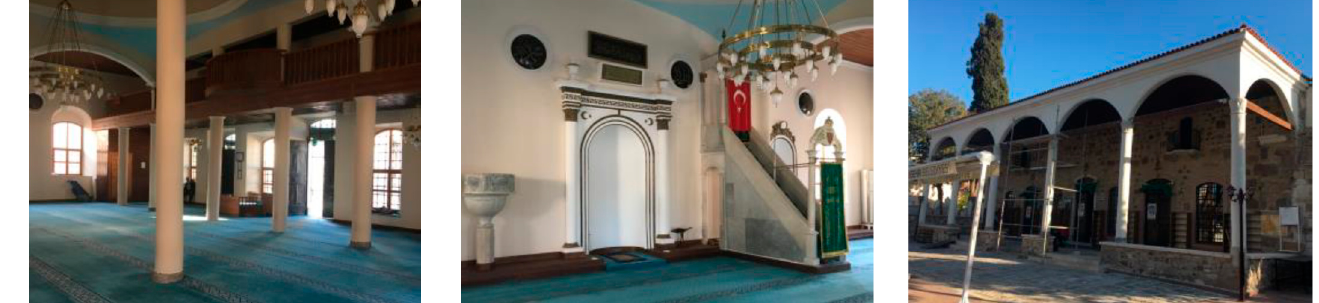
Figure 7. Main prayer hall of Mahkeme Mosque (photos by the authors).